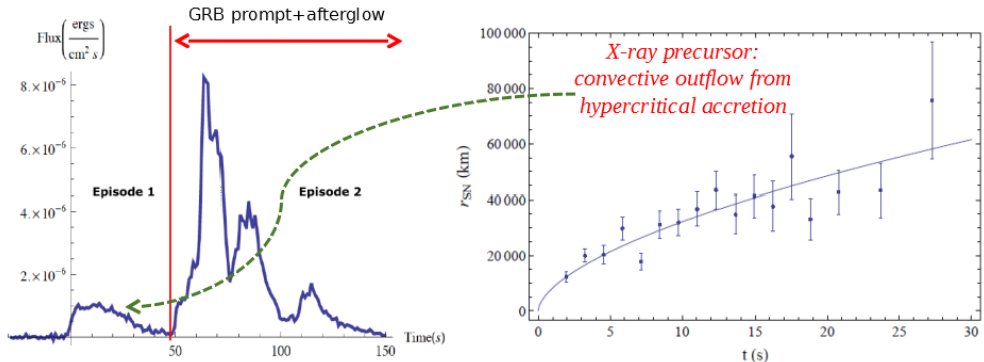
Figure 6. ( a ) Fermi-GBM (NaI 8–440 keV) light-curve of GRB 090618 (adapted from Figure 1 in [35]). ( b ) Expanding radius of the thermal blackbody emission observed in the “Episode 1” of GRB 090618 (adapted from Figure 2 in [35]). The interpretation of such an X-ray precursor as being due to the emission of the convective bubbles during the process of hypercritical accretion onto the NS was proposed for the first time in